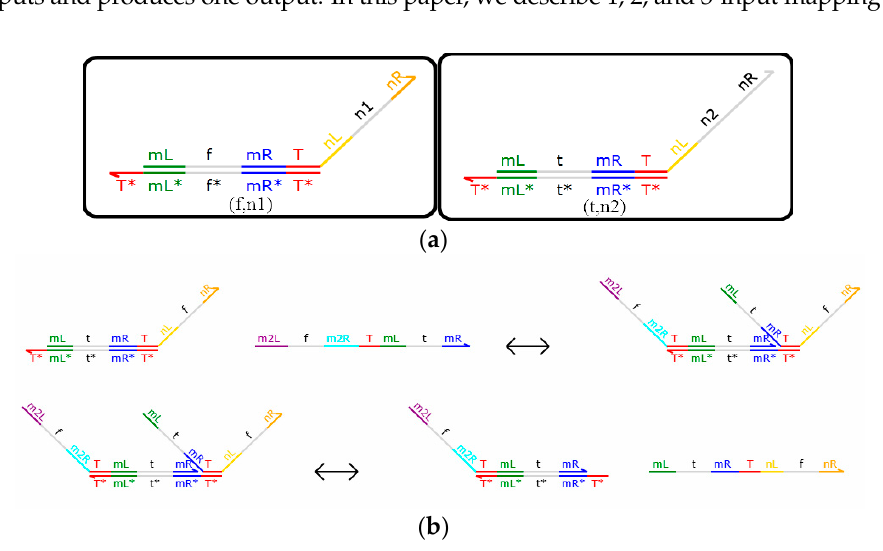
Figure 4. ( a ) 1-Mapping module.; ( b ) Reaction of the 1-mapping module.